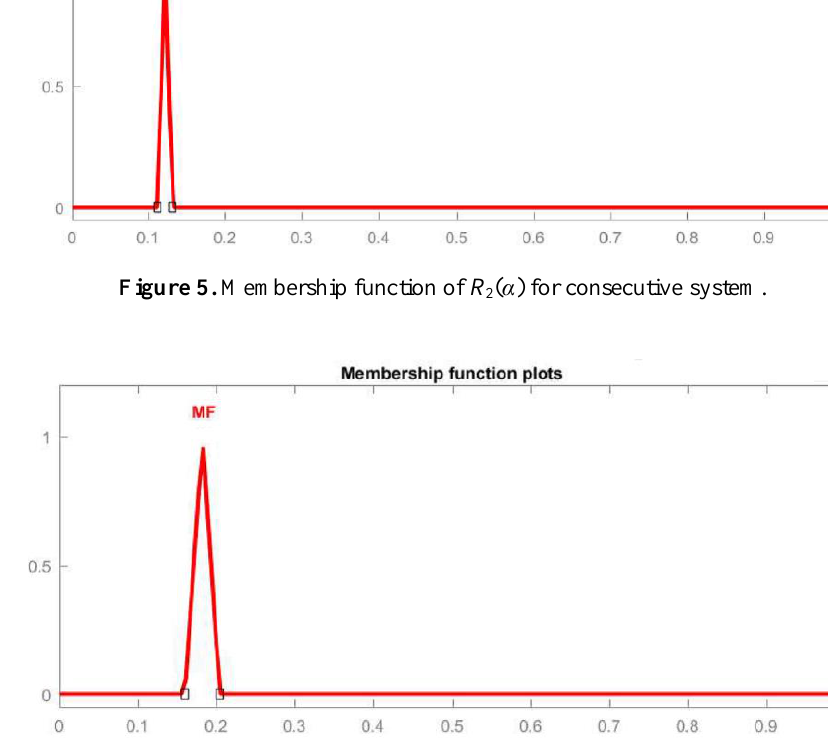
Figure 6. Membership function of R 3 ( α ) for consecutive system.